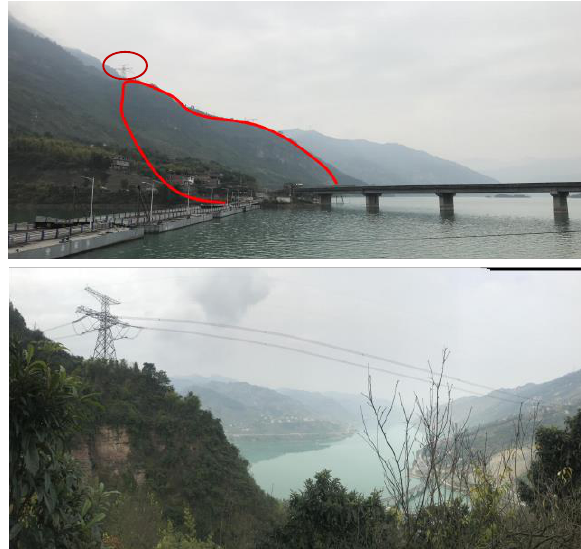
Figure 10. Landslide body and tower